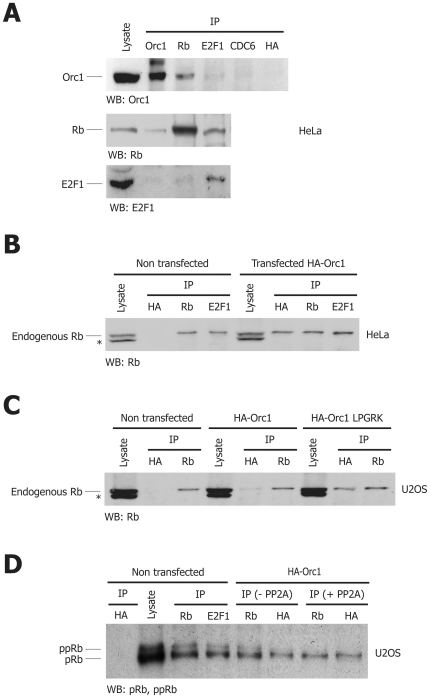
Orc1 forms a stable complex with hypo-phosphorylated Rb inside the cells.(A) Co-immunoprecipitation experiments performed with lysates from asynchronous HeLa cells using the indicated antibodies for immunoprecipitation and western blottings. (B) Immunodetection of endogenous Rb after co-immunoprecitation with exogenous HA-tagged Orc1 in transiently transfected asynchronous HeLa cells. Additional co-immunoprecipitations with Rb and E2F1 proteins in non-transfected and HA-Orc1-transfected HeLa cells were performed as controls. The band marked by an asterisk (*) represents an unspecific band detected with the mouse anti-Rb antibody IF8. (C) Endogenous Rb detected by western blotting after immunoprecipitation with anti-HA peptide antibody in non-transfected, wt HA-Orc1-, and mutant HA-Orc1 LPGRK-transfected U2OS cells. Additional immunoprecipitations for Rb were performed as controls on the same lysates. The band marked by an asterisk (*) represents an unspecific band detected with the mouse anti-Rb antibody IF8. (D) Immunoblotting to visualize the differently phosphorylated forms of endogenous Rb, after immunoprecipitation with anti-Rb and anti-HA peptide antibodies in U2OS cells not transfected or transfected with wt HA-Orc1, as indicated. Orc1 immunoprecipitated hypo-phoshorylated Rb, showing the same apparent mass as that obtained after treatment of total Rb immunoprecipitates with PP2A phosphatase.